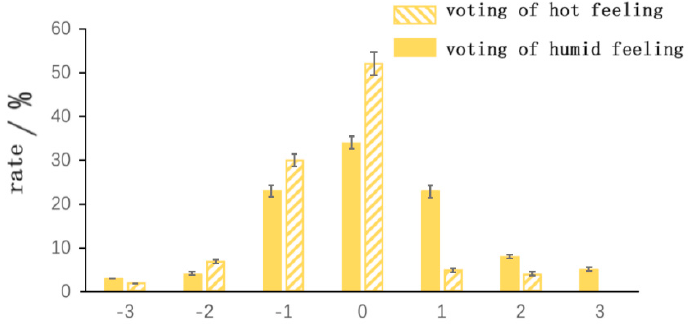
Figure 15. Frequency distribution of heat and humidity sensory voting (source: self–drawn).